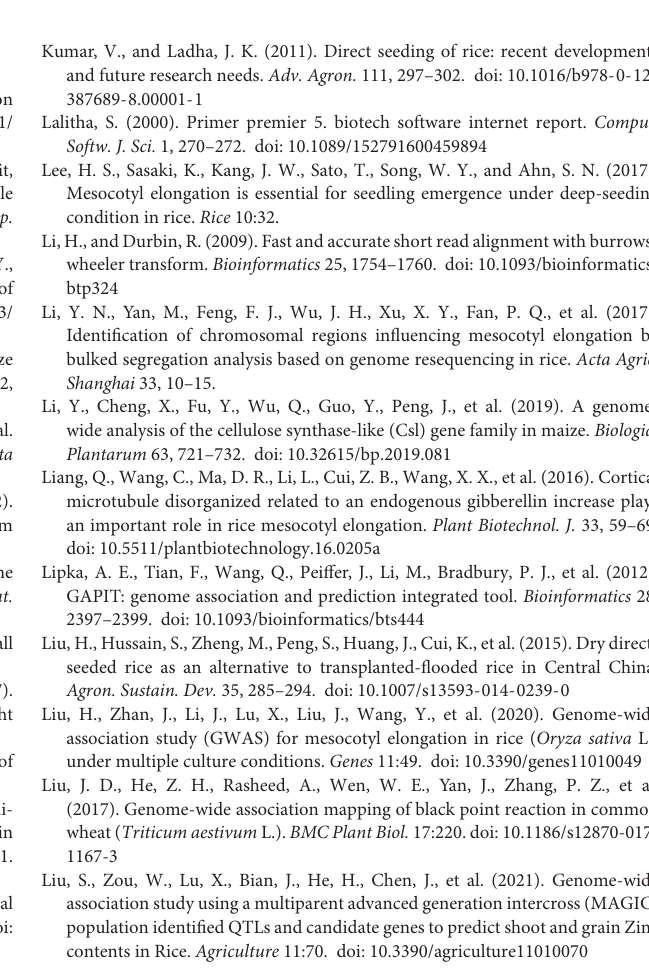
Supplementary Figure 2 | Distribution of mesocotyl length in XI-1A, AUS and XI-1B panel. Supplementary Figure 3 | LD decay along the whole genome of the AUS and XI-1A panel. Supplementary Figure 4 | Population and kinship analysis for the XI-1B panel. (A) PCA analysis; (B) Kinship analysis. Supplementary Table 1 | Mesocotyl length of the accessions from XI-1A panel. Supplementary Table 2 | Mesocotyl length of the accessions from AUS panel. Supplementary Table 3 | Details of the next-generation sequencing data for 12 F 2 populations. Supplementary Table 4 | Number of SNPs for the 12 F 2 populations. Supplementary Table 5 | GWAS for mesocotyl length in the XI-1A panel. Supplementary Table 6 | GWAS for mesocotyl length in the AUS panel. Supplementary Table 7 | Candidate genes in the loci identified by QTL-seq and GWAS. Supplementary Tables 8 | Primer information for qRT-PCR of the candidate genes. Supplementary Table 9 | Mesocotyl length and allele information for developed markers in XI-1B